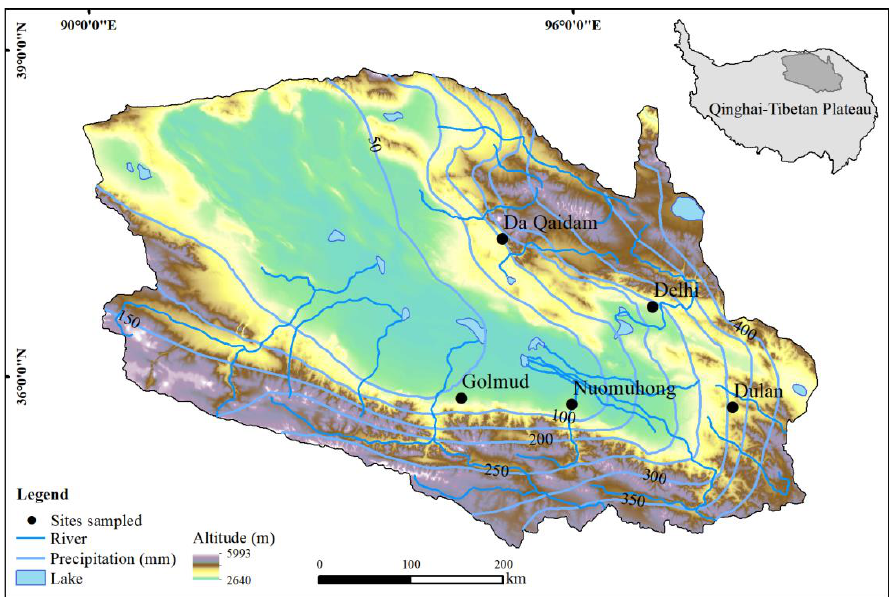
Figure 1. Field sampling sites in the eastern part of Qaidam Basin; the embedded mini-map shows the location of Qaidam Basin on the Qinghai – Tibetan Plateau. Table 1. Locations, the most dominant species and their relative coverage, altitude, climate conditions, and soil properties of sampling